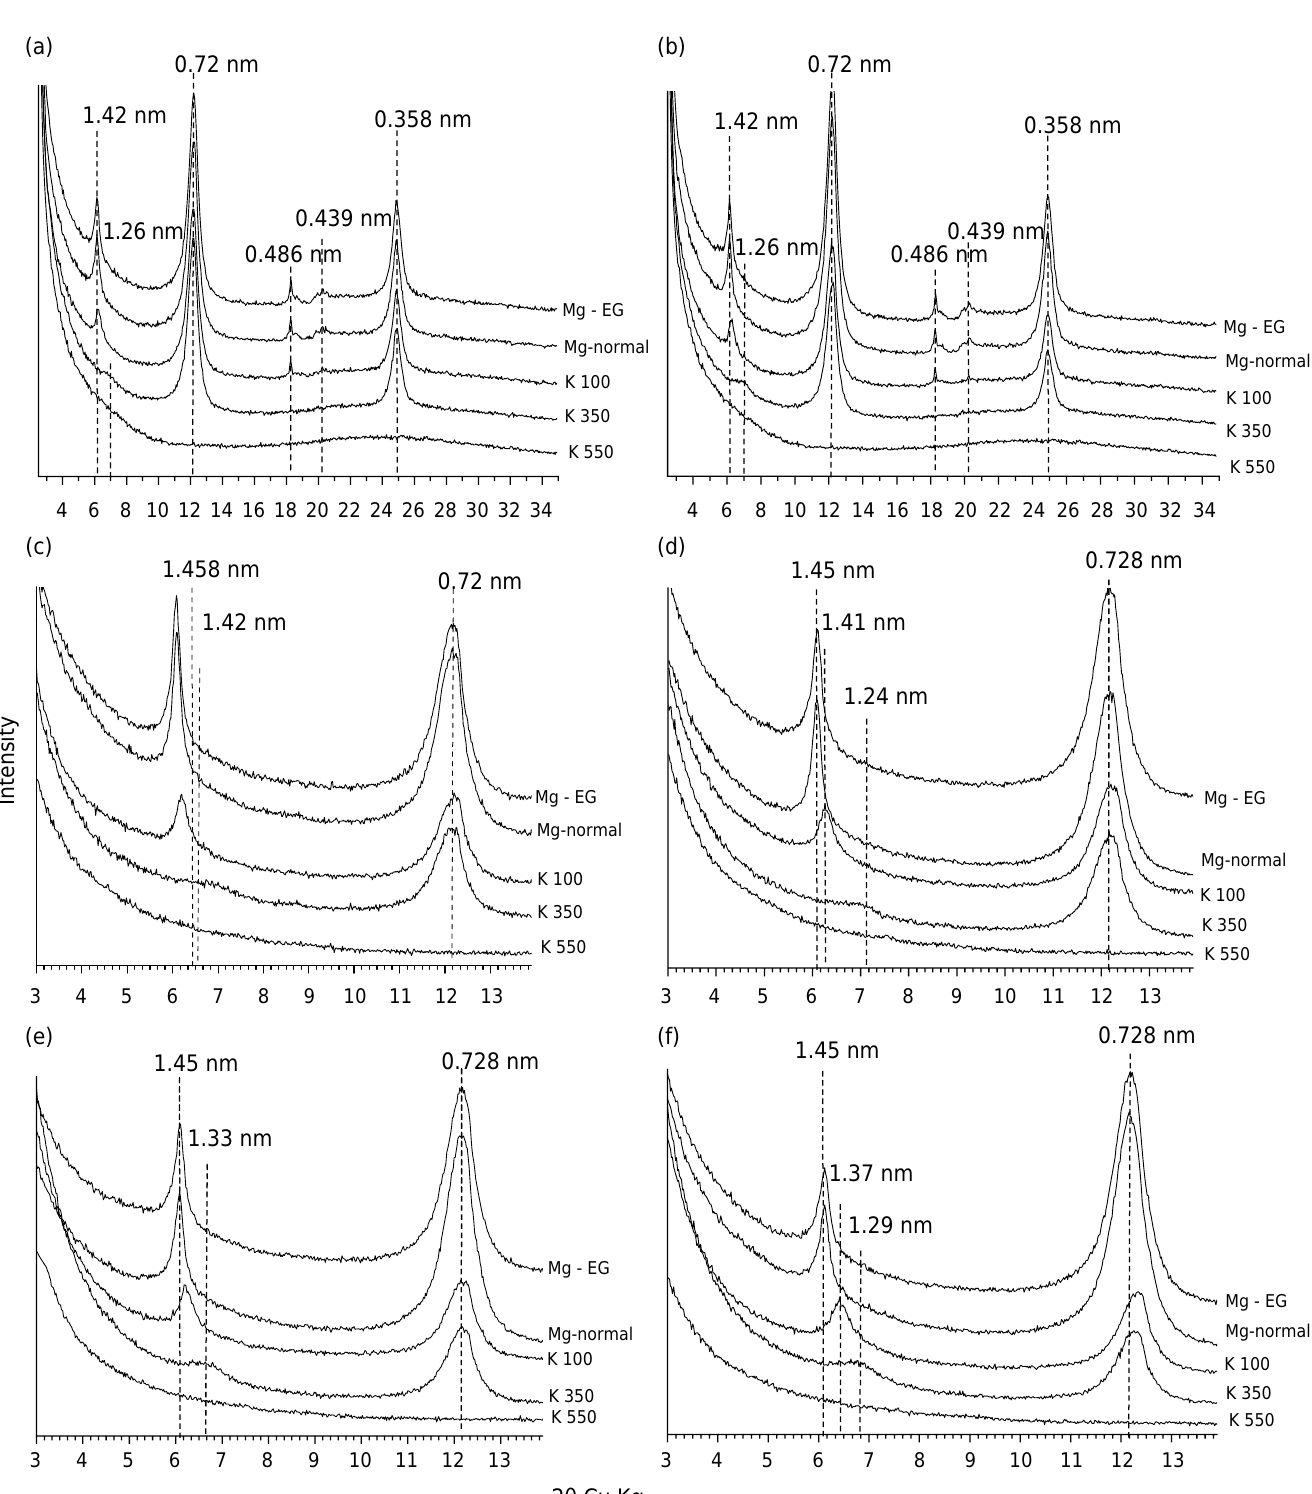
Figure 2. Clay fraction X-ray diffraction patterns of a Ferralsol from Paraná, Brazil, after greenhouse experiment: (a) F60 initial and (b) F380 initial; (c) F60T0, (d) F380T0, (e) F60T90, and (f) F380T90 corresponds to samples after the greenhouse experiment under contrasted K 2 O rate treatments (T0 = zero K; and T90 = 90 mg kg -1 per crop of K 2 O). Magnesium-saturated after drying at room temperature (Mg-normal), after ethylene glycol saturated (EG) and K-potassium after heating at 150 °C (K 150); 350 °C (K 350); and 550 °C (K